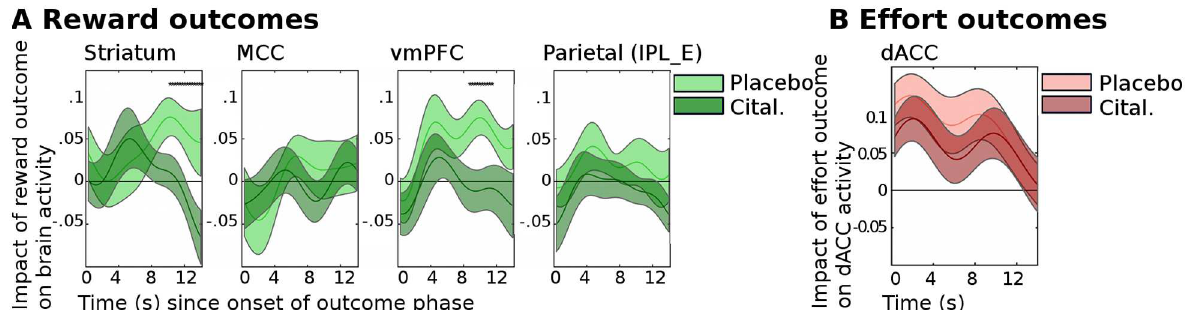
Fig 4. Citalopram does not increaseneural signals for reward or effort outcomes. (A) Shows the time course of the regression coefficients for the relative (chosenminus unchosenoption) reward magnitude outcomeson brain activity (analysisfGLM2) for the placebo(light green) and the citalopram(dark green) groups. We found that citalopramdid not increasethe relative reward magnitude outcome signal(ANOVA, testing for a main effect of group across all areas: F(1,27) = 1.19, p = 0.29). On the contrary, a more lenient time point—by—time point t test analysisof the time courses revealedthat in striatum and vmPFC, citalopram, in fact, decreasedthe relative rewardmagnitudeoutcome signal late in the outcome phase( * p < 0.05 for time point—by—time point two-sided t tests). (B) Similarly, for dACC, citalopram did not increase the codingof the relativeeffort outcome signal (t(27) = 0.65, p = 0.52). Abbreviations: ventral striatum (striatum), midcingulate cortex (mCC), ventromedial prefrontalcortex (vmPFC), parietalcortex (Parietal, IPL_E [38]), dorsal anterior cingulatecortex (dACC). Data for individual participantscan be found in S4